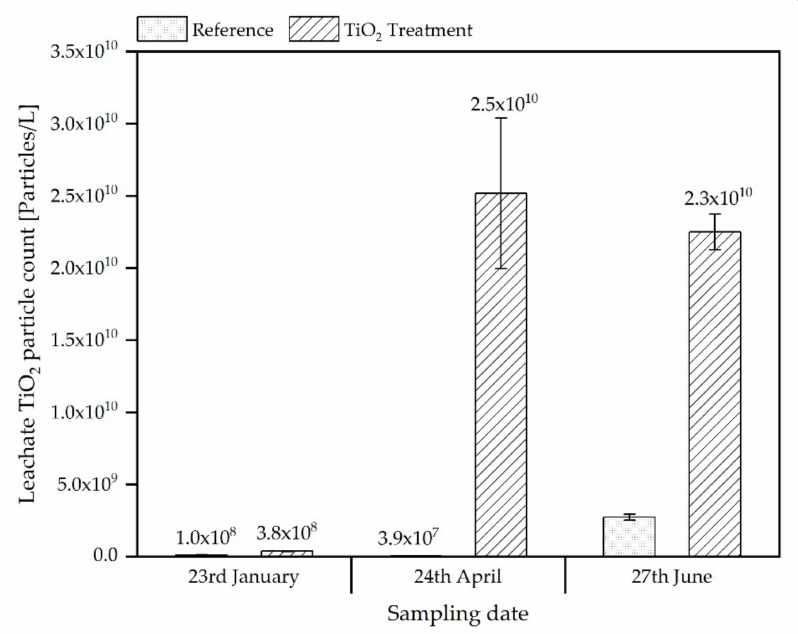
Figure 4. TiO 2 particle concentrations (Particles/L) determined in leachates from pilot scale simula- tion reactors collected after watering of the soil at end of the respective preceding winter